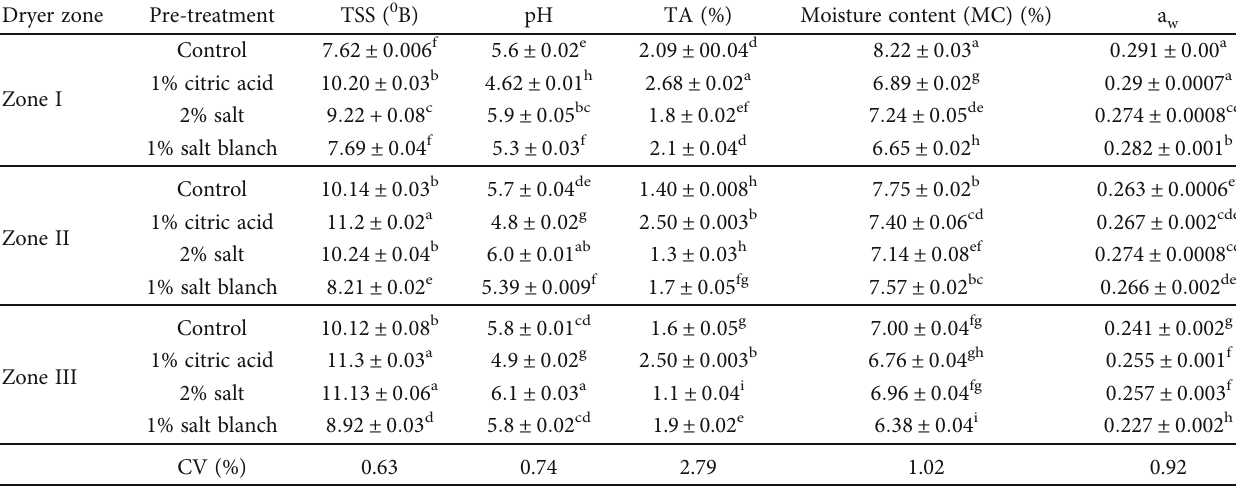
Table 7: Mean of chemical properties and proximate of pumpkin powder obtained from a combination of zone and pretreatments. Dryer